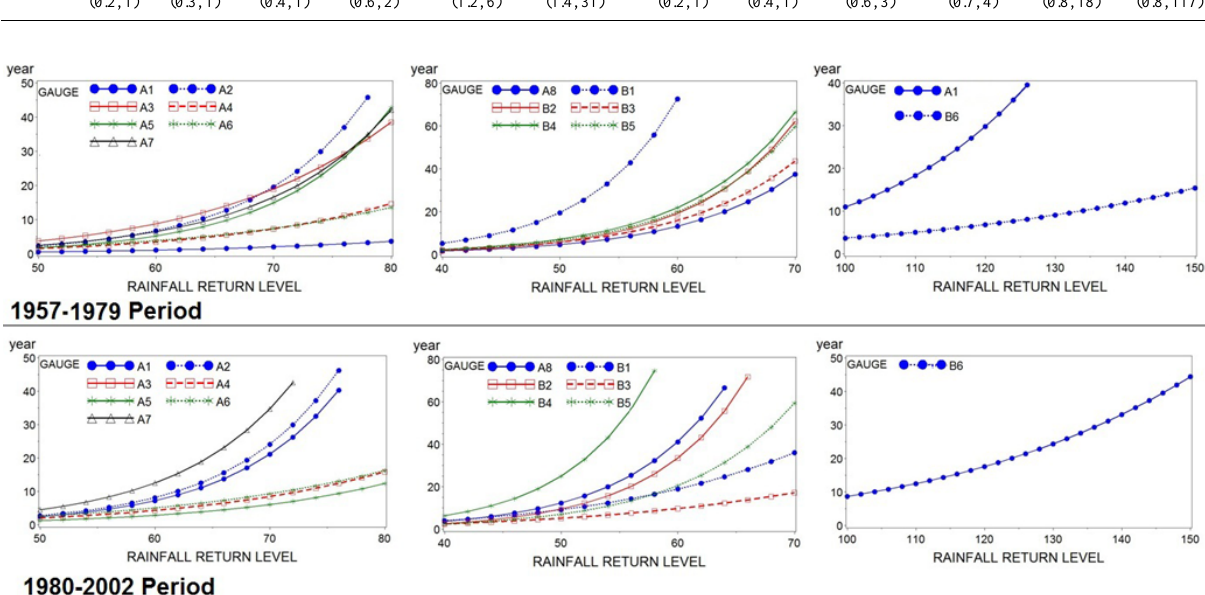
Fig. 7. Return time (year) as function of maximum rainfall return level (mmday − 1 ). Top plots are for the first period (1957–1979), and the bottom for the second period